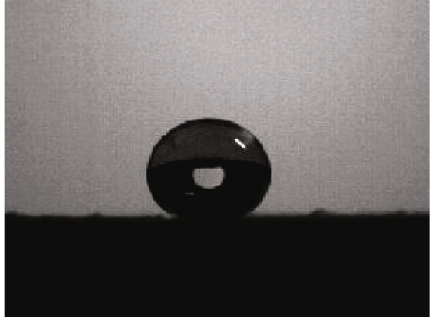
Figure 5: Static contact angle of the polymer fi